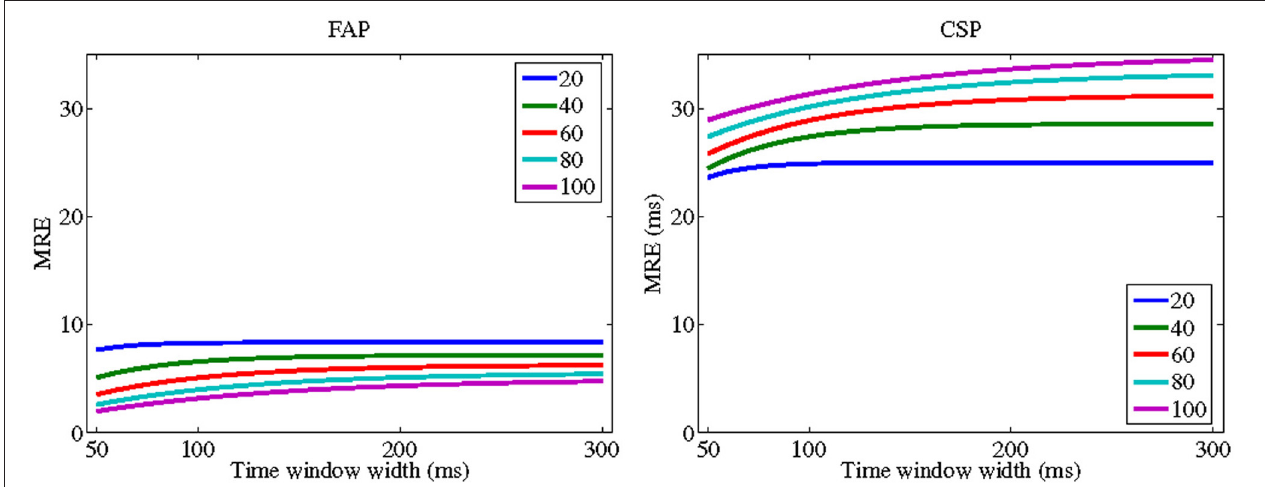
FIGURE 1 | TWIN predictions for crossmodal response enhancement (CRE) for focused attention paradigm (FAP) (left panel) and crossmodal signals paradigm (CSP) (right panel) as a function of time window width ( ω ). Each curve corresponds to a specific intensity parameter of the stimuli